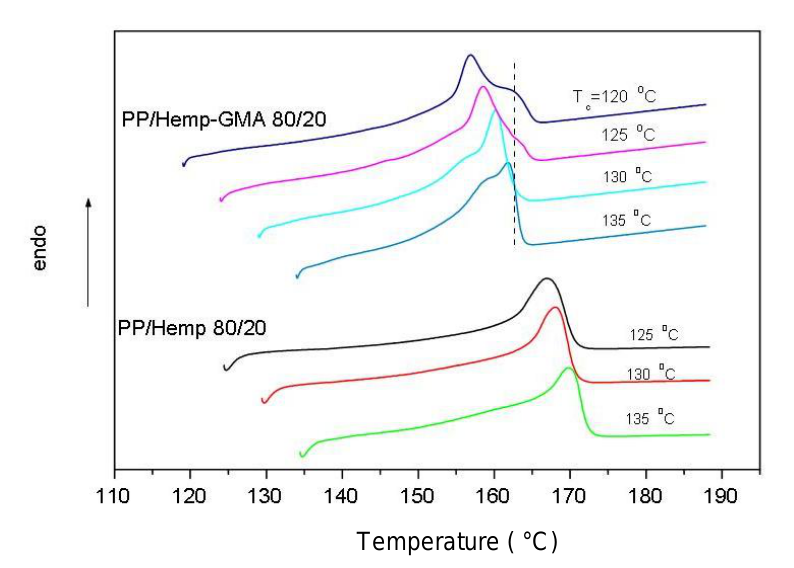
Figure 6 . DSC melting curves of PP/Hemp and PP/Hemp-GMA composites isothermally crystallized from the melt at various T (heating rate: 10 °C/min). c